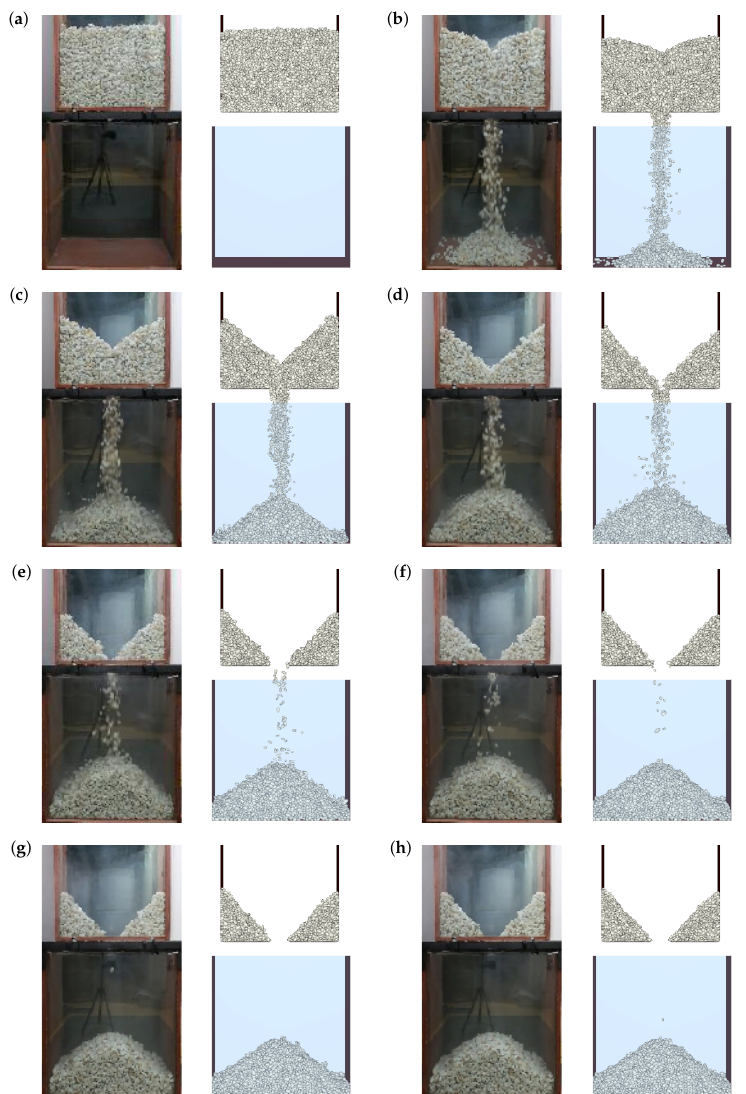
Figure 10. Graphical comparison of the Draw Down Test used in validation, on the left is a photograph of the test and on the right an image of the DEM simulation: ( a ) t = 0 s, ( b ) t = 1 s, ( c ) t = 2 s,